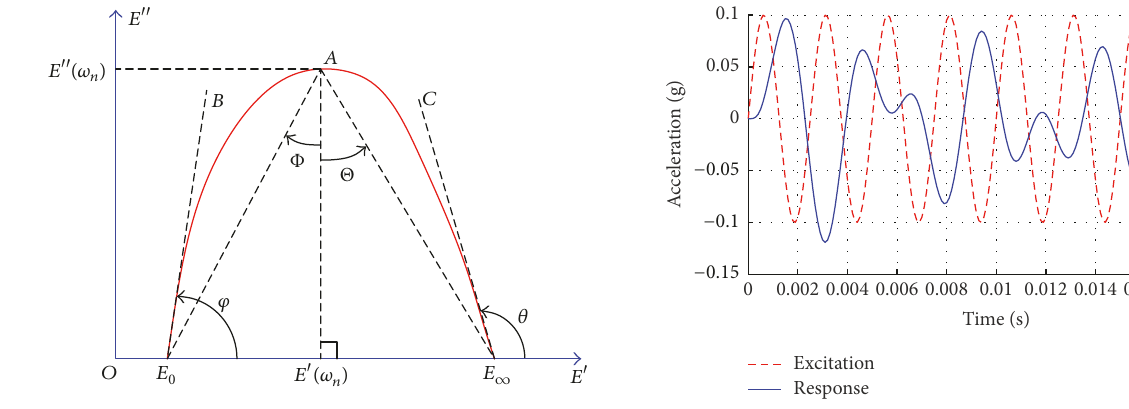
Figure 6: Cole-Cole curve.